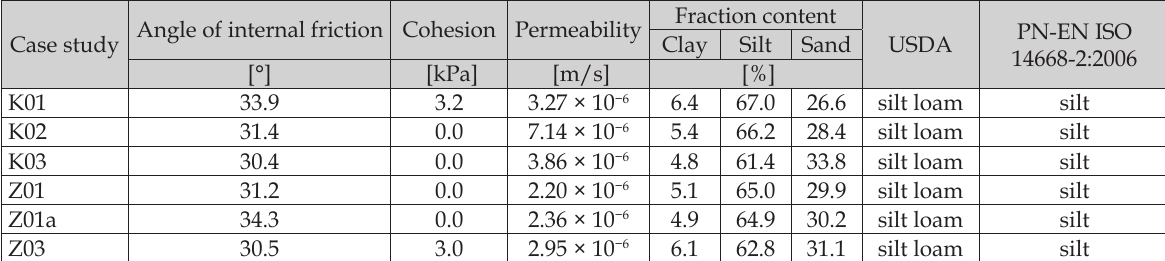
Table 2. Main geotechnical parameters of loess cover at each